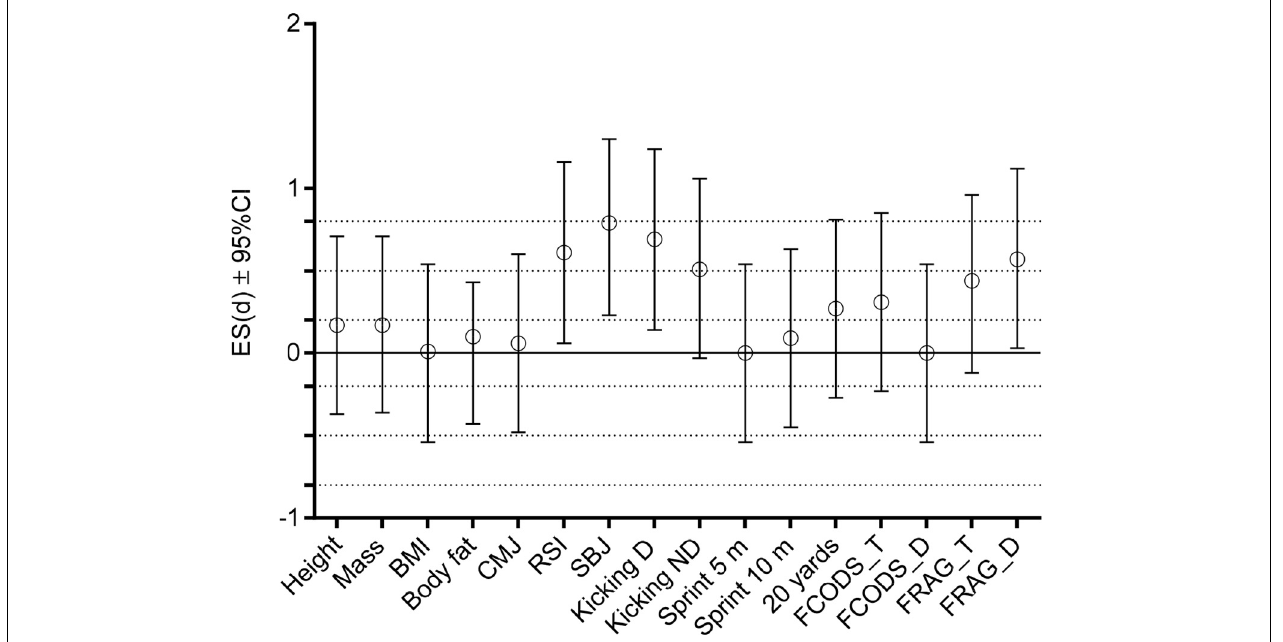
FIGURE 3 | Effect size differences between top-level players and high-level players in studied anthropometric and physiological variables. CMJ, countermovement jump; RSI, reactive strength index; SBJ, standing broad jump; Kicking D, kicking speed dominant leg; Kicking ND, kicking speed non-dominant leg; 20 yards, generic change of direction speed test over 20 yard distance; FCODS_T, futsal specific change of direction speed test without dribbling; FCODS_D, futsal specific change of direction speed test with dribbling the ball; FRAG_T, futsal specific reactive agility test without dribbling; FRAG_D, futsal specific reactive agility test with dribbling the ball. Dashed lines present ES ranges ( < 0.02 = trivial; 0.2–0.6 = small; > 0.6–1.2 = moderate; > 1.2–2.0 = large differences).